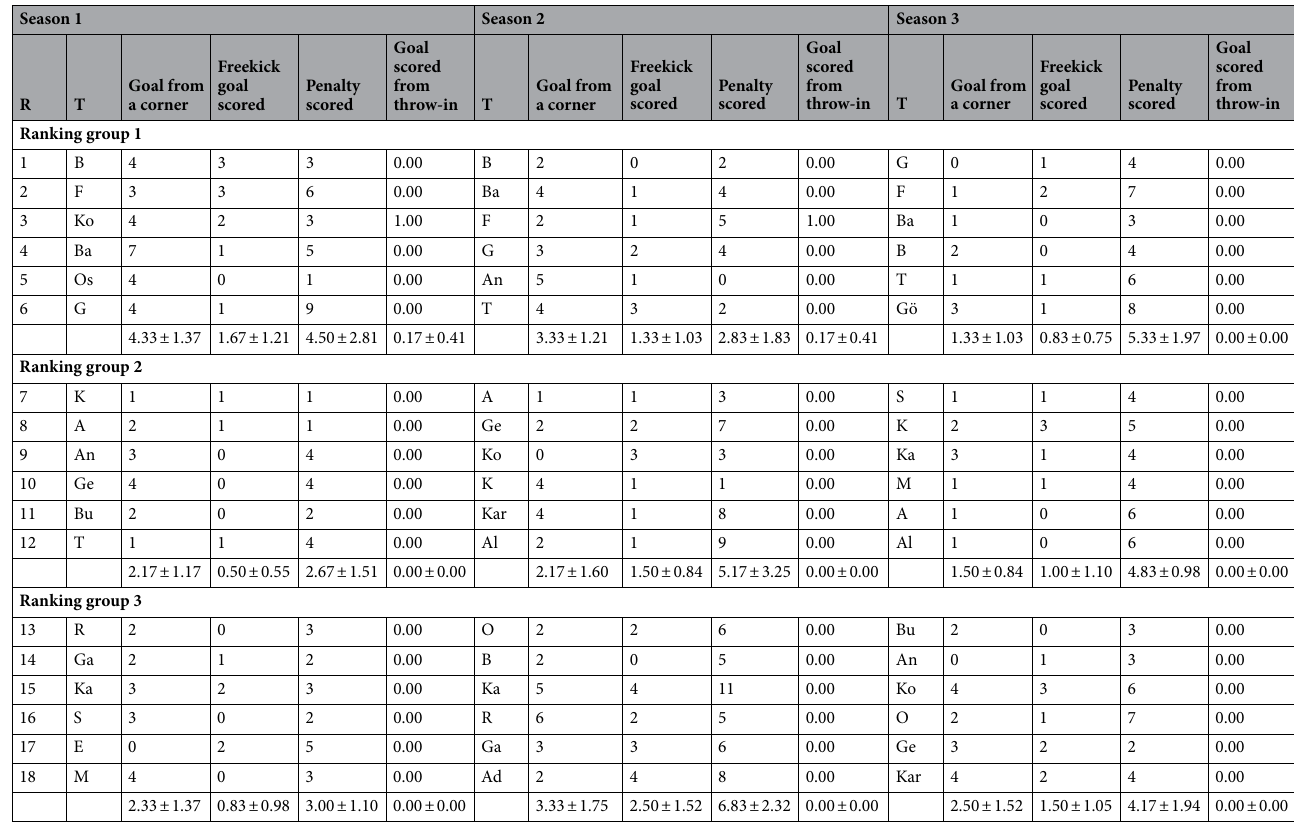
Table 5. Technical data of the player during the match [Goal from a corner. Freekick goal scored. Penalty scored and Goal scored from throw-in (mean and SE)] as a function of Ranking group and Season Condition. Data are presented as means and standard deviations. TD: Total Distance; THID: Total high intensity running distance; TS: Total number of sprints; TSD: Total sprint distance; R: Ranking; Teams: Beşiktaş (B); Fenerbahçe (F); Konyasport (Ko); Başakşehir (Ba); Osmanlıspor (O); Galatasaray (G); Kasımpaşa (K); Akhisar (A); Antalyaspor (An); Gençlerbirliği (Ge); Bursaspor (Bu); Trabzonspor (T); Rizespor (R); Gaziantepspor (Ga); Kayserispor (Ka); Sivasspor (S); Eskişehirspor (E); Mersin İY (M); Karabükspor (Kar); Alanyaspor (Al); Adanaspor (Ad). Göztepe (Gö). and Malatyaspor